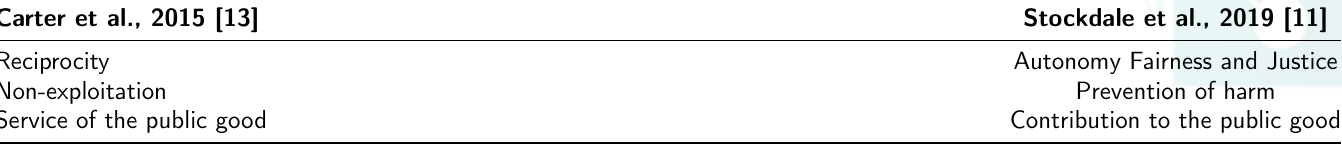
Table 1: Core tenets of a social license for secondary uses of health data Carter et al., 2015